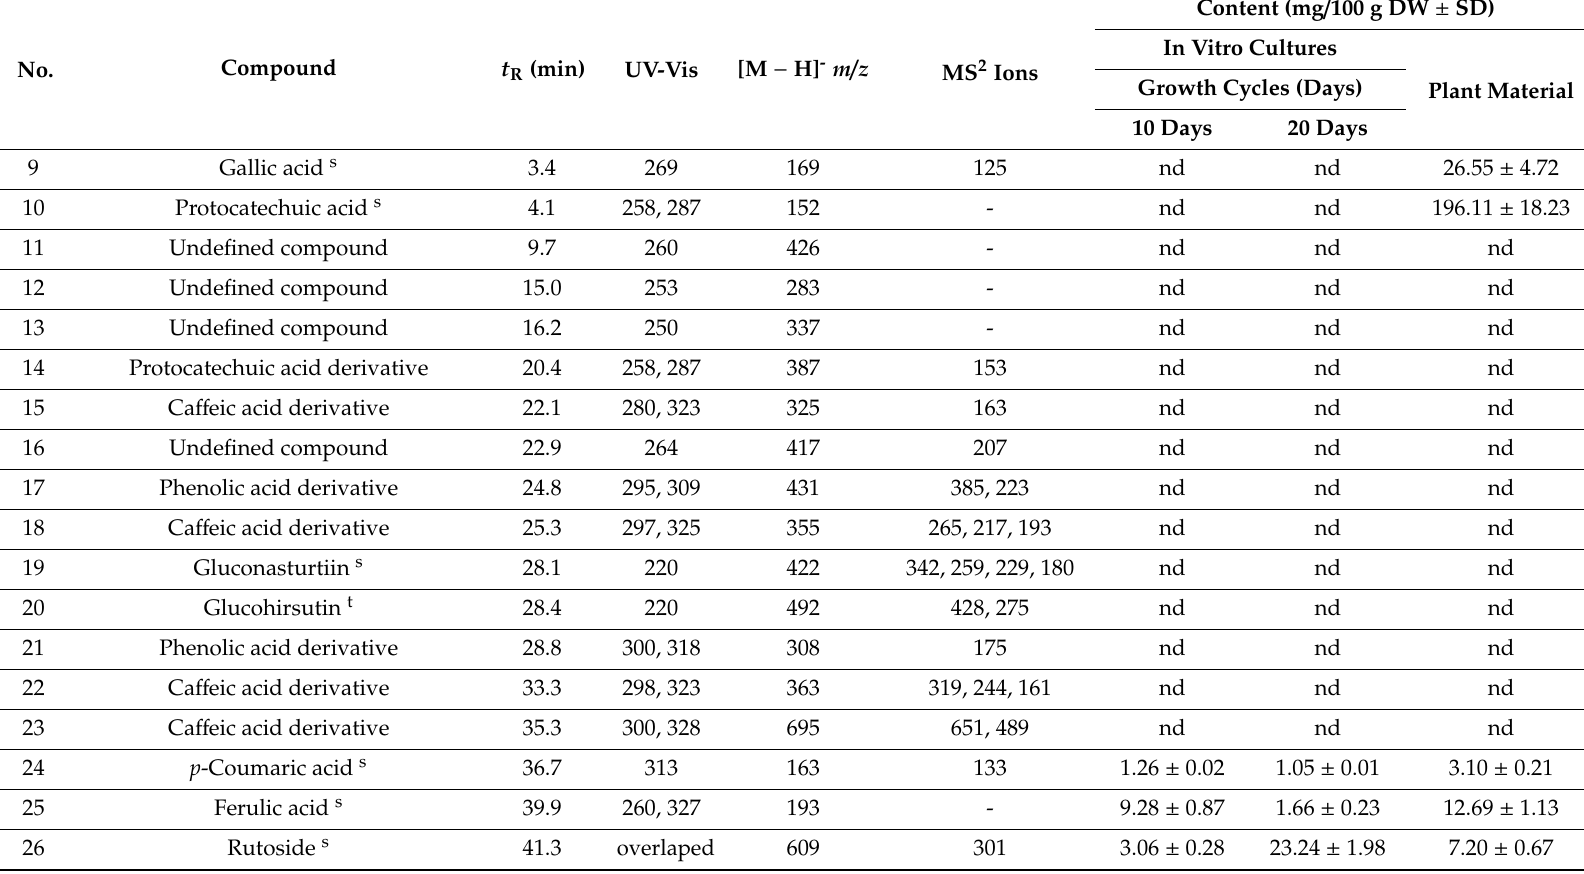
Table 3. Phenolic profile and contents of detected compounds in N. o ffi cinale extracts from bioreactor microshoots cultures and from the herb of the parent plant confirmed by UHPLC-DAD-ESI-MS and